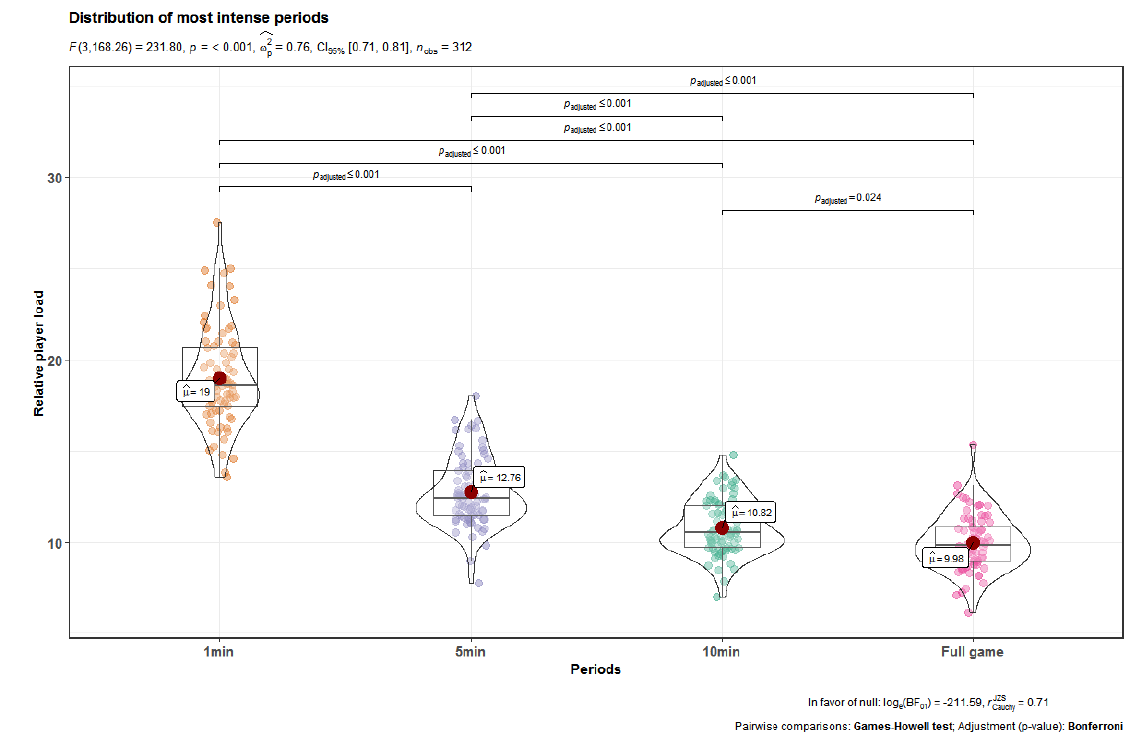
Figure1. Thedescriptiveandcomparativeanalysisofaveragedemandsamongdi ff erentintenseperiods. Figure 1. The descriptive and comparative analysis of average demands among different intense periods.